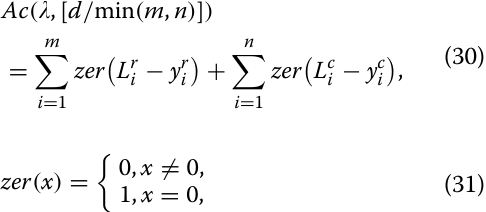
maximum of diagnostic accuracy. In Figure 6, four differ-